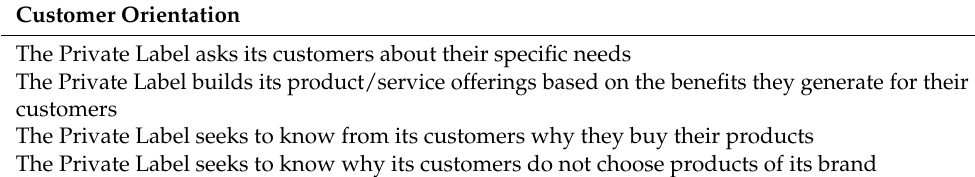
Table 5. Items removed from the measure